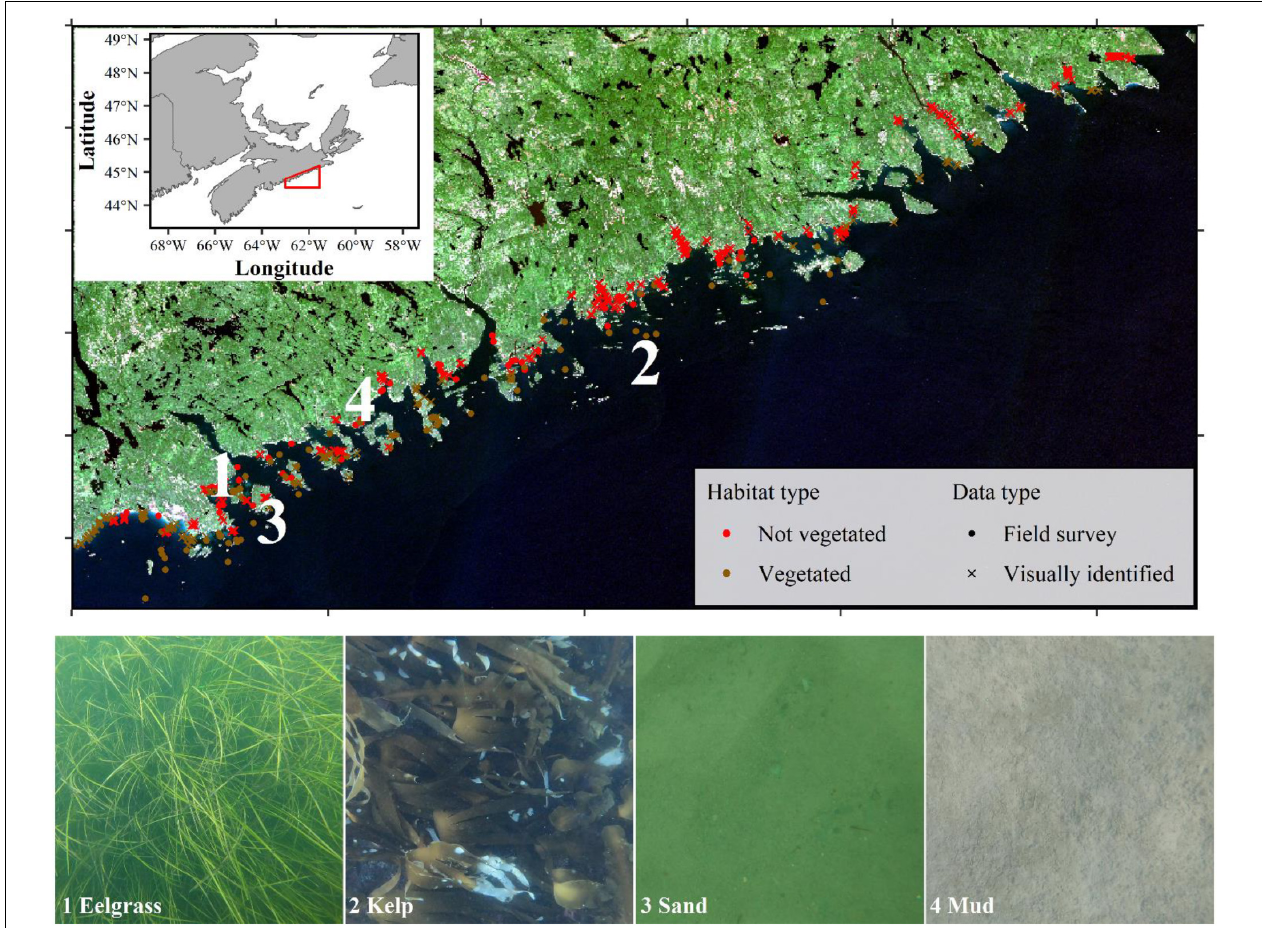
FIGURE 1 | Atmospherically corrected true-color composite of the Sentinel-2 tile (T20NQ) of the Eastern Shore Islands in Nova Scotia, Canada acquired on September 13, 2016. Dots indicate stations where field survey data were collected, triangles indicate visually identified points, colors show where vegetated habitat is known and not known to occur. Numbers relate to image-stills of select habitat types occurring in the